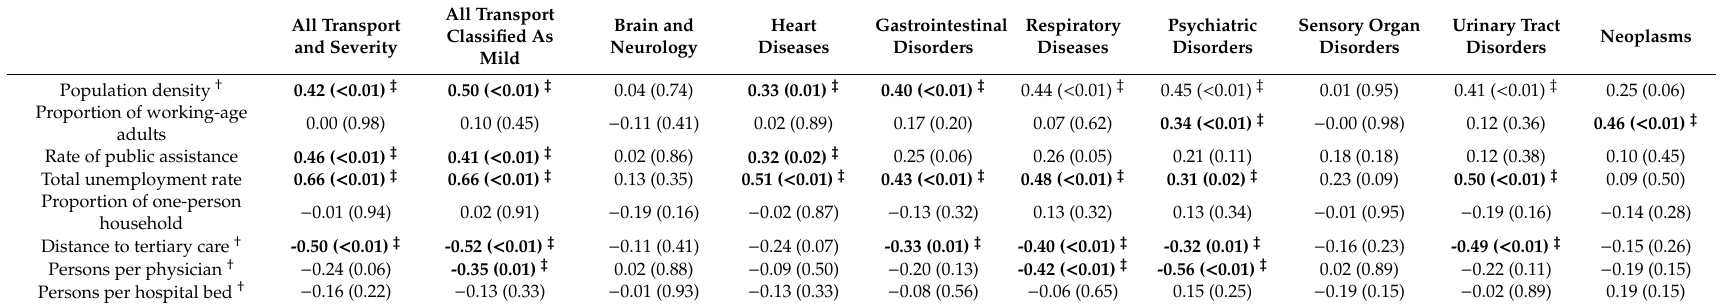
Table 1. Univariate relationship between the standardized transport ratio and sociodemographic / sociocultural